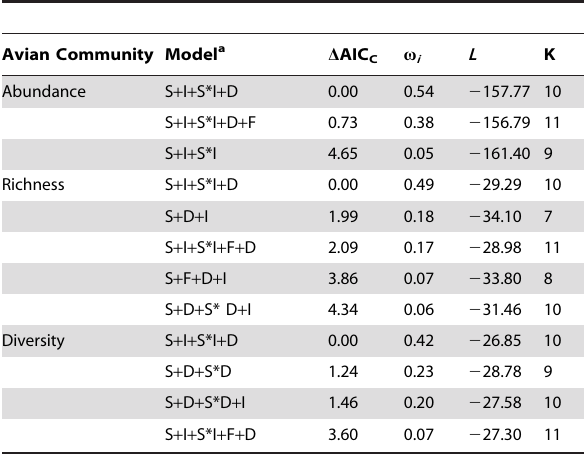
Table 1. Most-supported models of avian abundance, richness, and diversity at 20 buildings in 2010 in Illinois, USA.